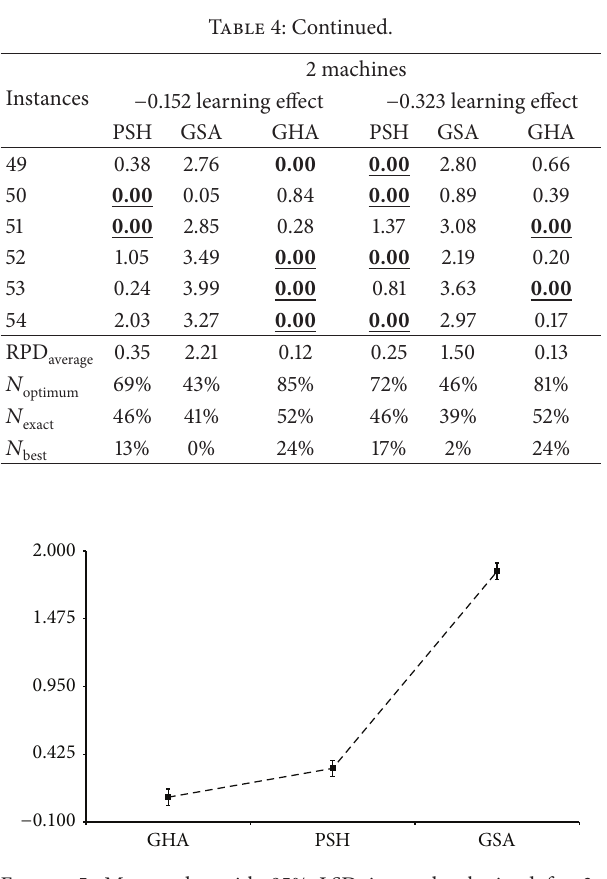
Figure 5: Means plot with 95% LSD intervals obtained for 3- machine